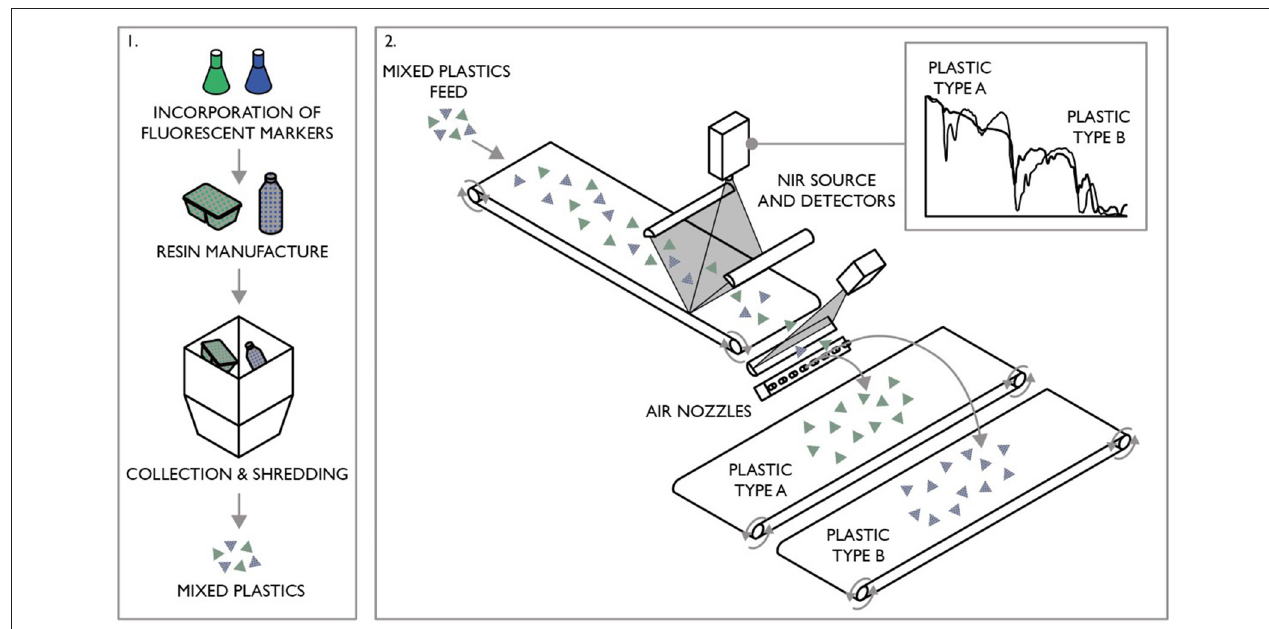
FIGURE 4 | The basic concept of plastic identification and sorting based upon the automated sorting of plastic waste labeled by fluorescent tracers (Brunner et al., 2015).